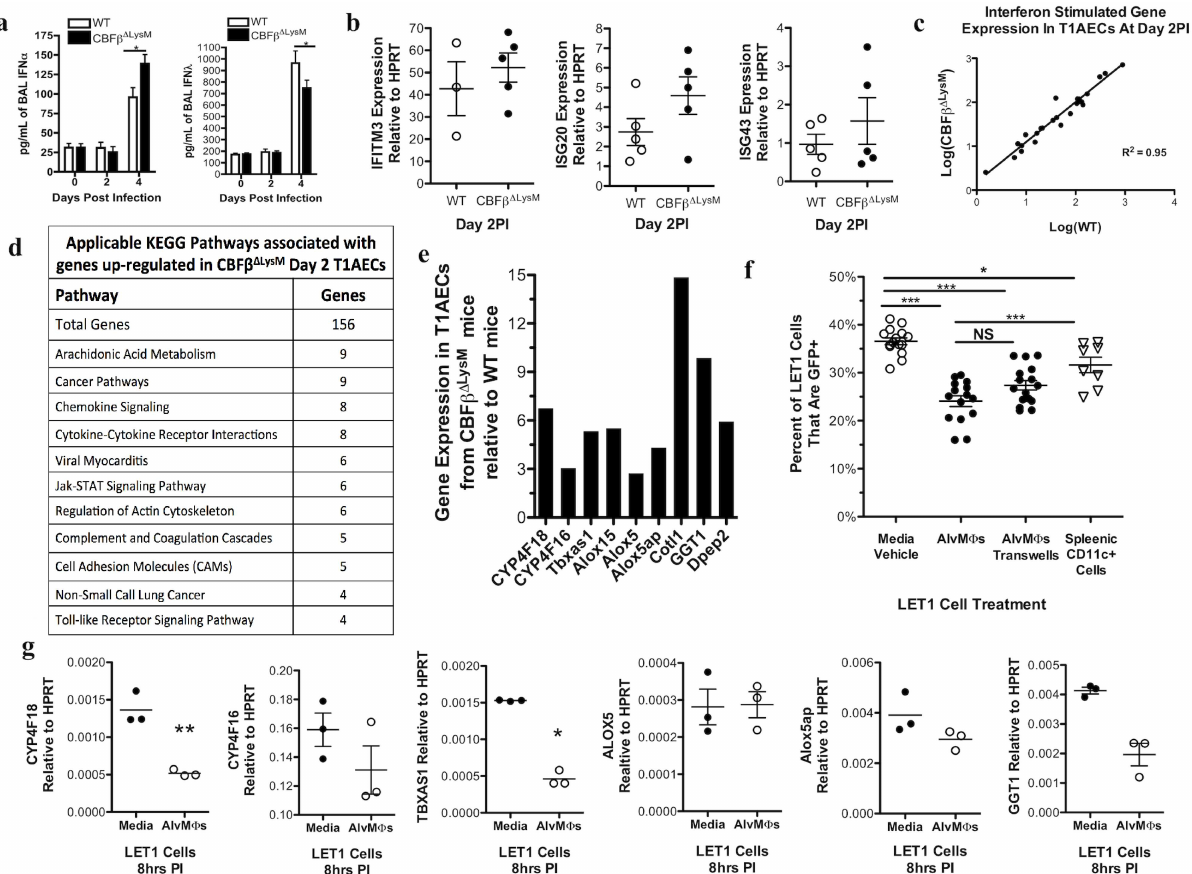
Fig 5. AlvM Φ ssuppress T1AEC expressionof arachidonic acid metabolism pathway genes. a-e) WT and CBF β Δ LysM mice were infected i.n. with a 0.1LD 50 of A/PR/8. a) IFN α and IFN λ protein in the BAL fluid prior to and duringIAV infection. Representative interferon stimulatedgenes b) detected by qRT-PCR of wholelung homogenates c) and detected by RNAseq on sorted T1AECs at day 2 PI. d) Genes identifiedas over expressedin T1AECs from CBF β Δ LysM mice at day 2PI were groupedby pathway analysis. e) Arachidonic acid metabolismgenesdifferentiallyexpressedas determinedby RNAseq. f) Percent of infected (GFP+) LET1 cells at 24hourspost infection when culturedwith media vehicle, AlvM Φ sdirectly, AlvM Φ sin transwellinserts or directly with splenicCD11c+ cells. g) Expressionof the correspondingarachidonic acid metabolismpathway genesby qRT-PCR at 8 hours post infection in LET1 cells culturedalone or with AlvM Φ s. a) BAL fluid was isolated from 4–10 mice per genotypeat each indicatetime point. c-d) 2–3 samples of pooledT1AECs from day 2 PI mice were used for RNAseq. For in vitro analyses, data were pooledfrom or is representative of a minimum of 3 experiments. Error bars are standard error mean. Statistical analysisis a) 2-way ANOVA, c) a linear regression analysisor f) 1-way ANOVA. * indicatesP < .05, ** for P < .001 and *** for P < .001. N.S. is not